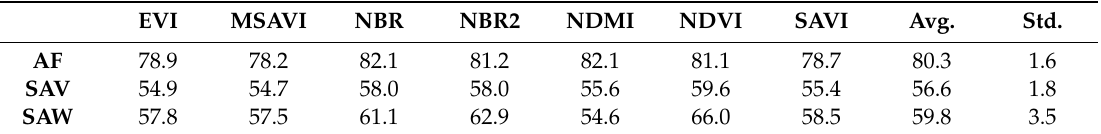
Table 2. Overall accuracy results (in percentage) from all vegetation disturbance maps—Atlantic forest (AF), savanna (SAV), and semi-arid woodland (SAW). Average and standard deviation by vegetation domain are also presented.